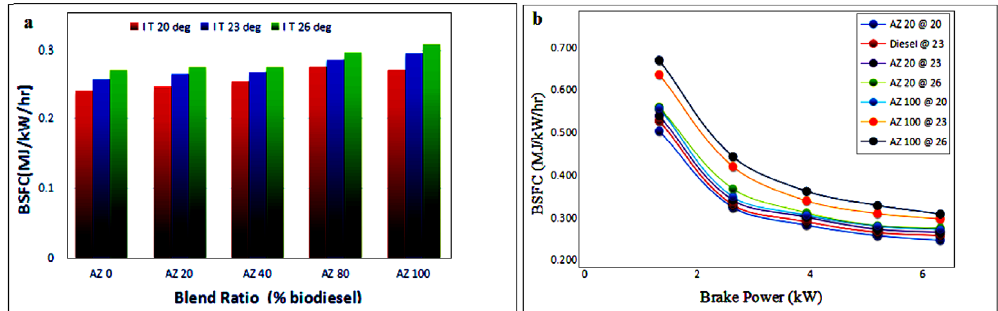
Figure 6. Brake Speci fi c Fuel Consumption vs. bio blends and brake